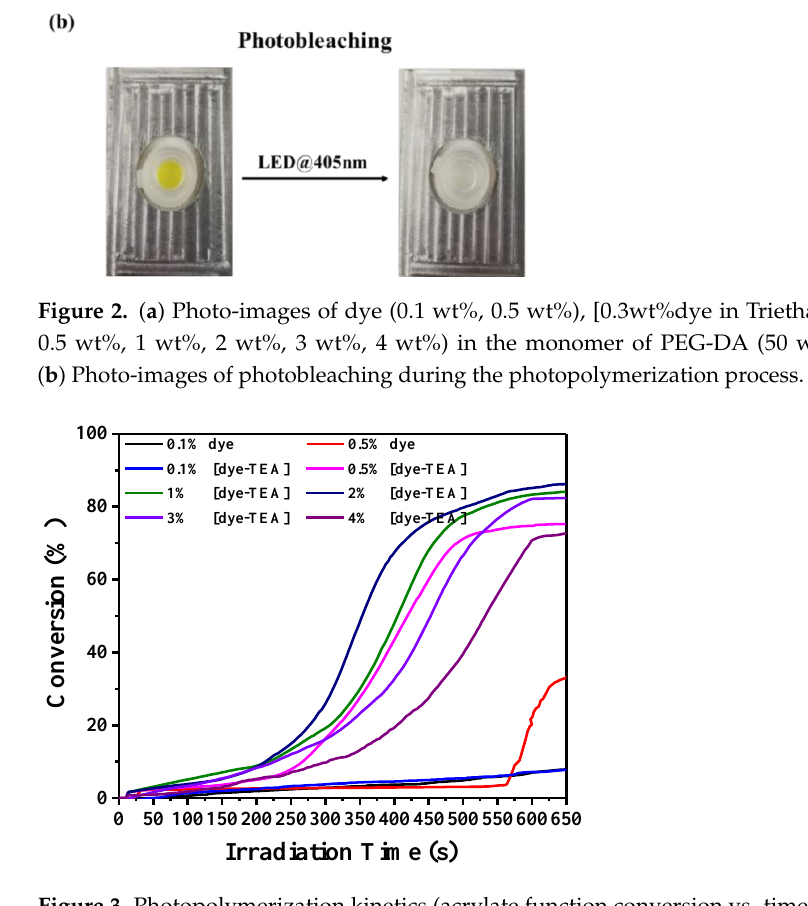
Figure 3. Photopolymerization kinetics (acrylate function conversion vs. time) of PEG-DA (50 wt% PEG-DA/50 wt% water) aqueous monomer initiated by dye (0.1 wt%, 0.5 wt%) and [dye-TEA] (0.1 wt%, 0.5 wt%, 1 wt%, 2 wt%, 3 wt%, 4wt%) in laminate upon irradiation with a LED @ 405 nm with the thickness about 2 mm. The irradiation starts at t = 10s. Table 1. Summary of the final function conversions of waterborne monomers (PEG-DA) under LED @ 405 nm initiated by dye (0.1 wt%, 0.5 wt%) and [dye-TEA] (0.1 wt%, 0.5 wt%, 1 wt%, 2 wt%, 3 wt%, 4 wt%) in laminate upon LED @ 405 nm with a thickness of about 2 mm. Final Acrylate Function Conversions of PEG-DA Aqueous Monomers 0.1% dye